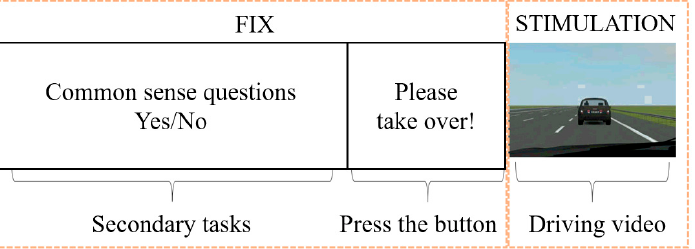
Figure 6. Flow diagram of a complete fMRI experiment of simulated takeover (the scan between adjacent stimulus tasks is called “fix”.).